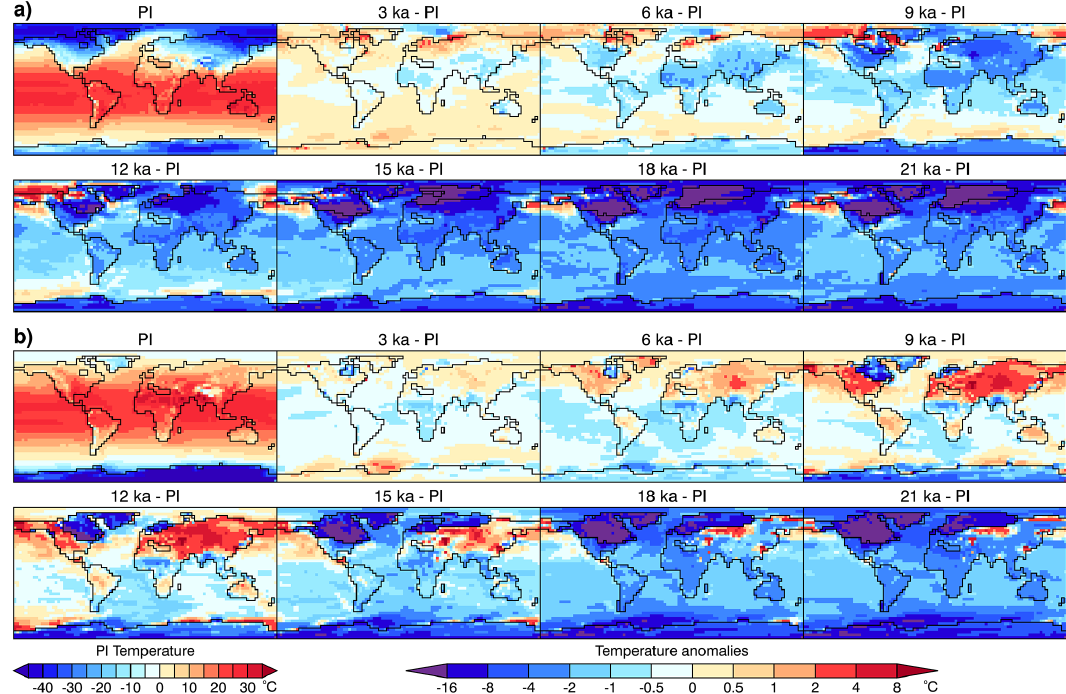
Figure 6. Simulated seasonal average 2m air temperature anomalies relative to PI. (a) December, January, and February and (b) June, July, and August.